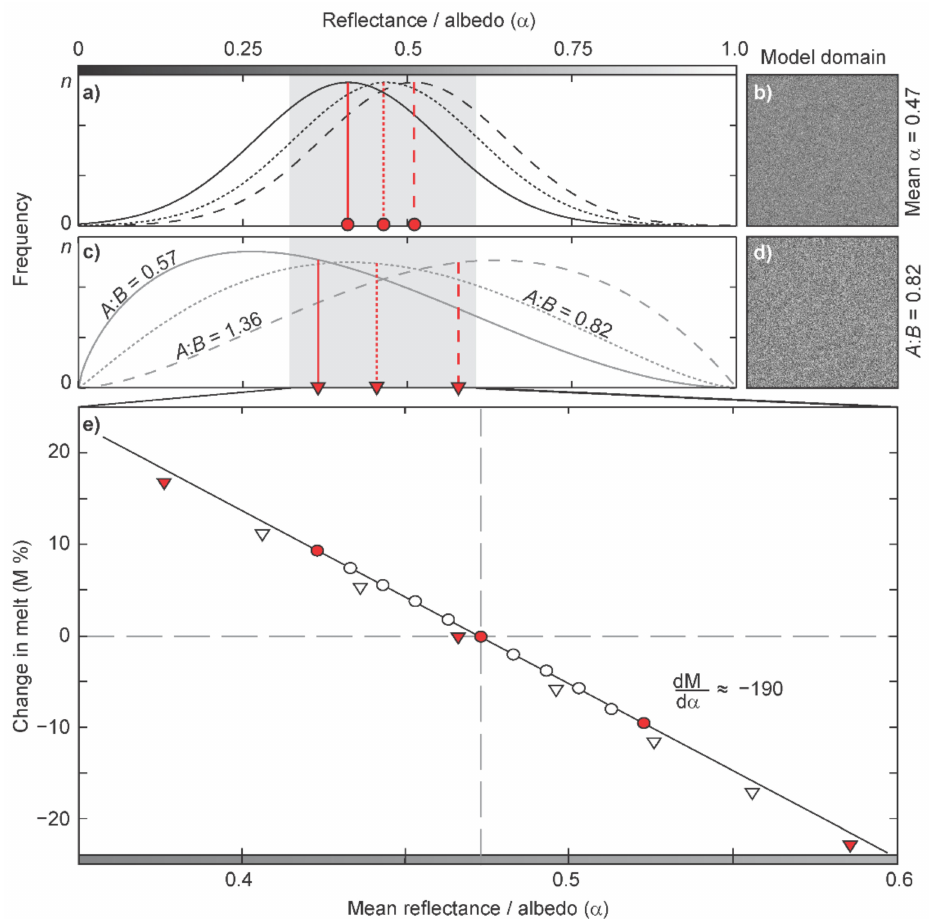
Figure 4. Simplified schematic of the reflectance scenarios used to test the sensitivity of melt prediction to high-resolution reflectance variability with ( a ) examples of the normal distributions and ( b ) associated spatial plot of the 600 × 600 model domain input scenario (mean α = 0.468, σ = 0.14), and ( c ) examples of the beta distributions and ( d ) a plot of the albedo input for A : B = 0.82. In ( a , c ), distributions with the lowest and highest mean α are shown with solid and dashed vertical lines, respectively; in ( b , d ), albedo is in greyscale, from black ( α = 0) to white ( α = 1). ( e ) Illustrates the linear increase in melt following reduction in mean surface reflectance for the normal distribution (circles) and for the beta distributions (triangles) focused on the window 0.35 < α < 0.6. The filled circles and triangles in ( e ) represent the reflectance distributions and associated means shown in ( a , c